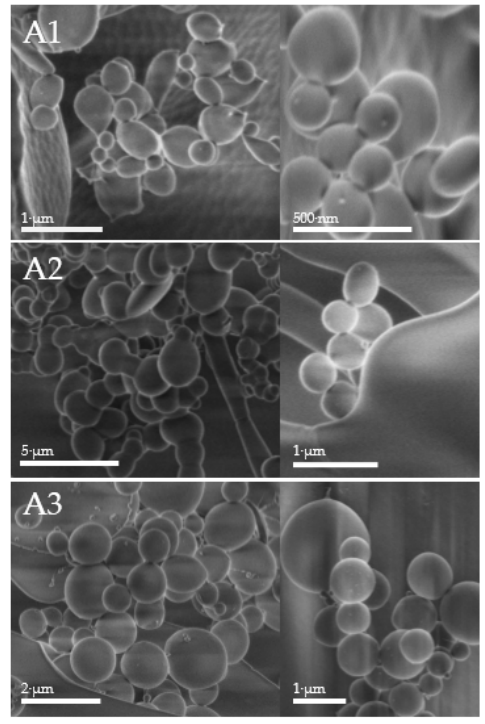
Figure 3. Scanning electron microscopy (SEM) of obtained particles A1–A3. The diameters measured under the SEM vacuum conditions were in the same range for the evaluated polymers